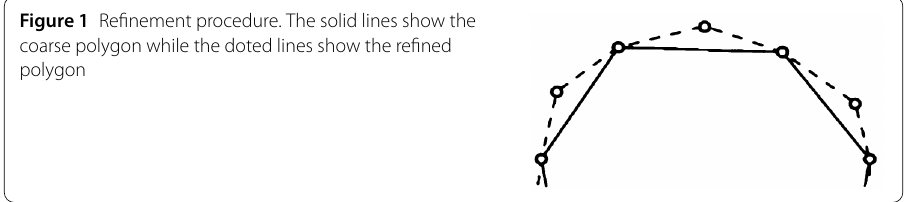
Figure 1 Refinement procedure. The solid lines show the coarse polygon while the doted lines show the refined